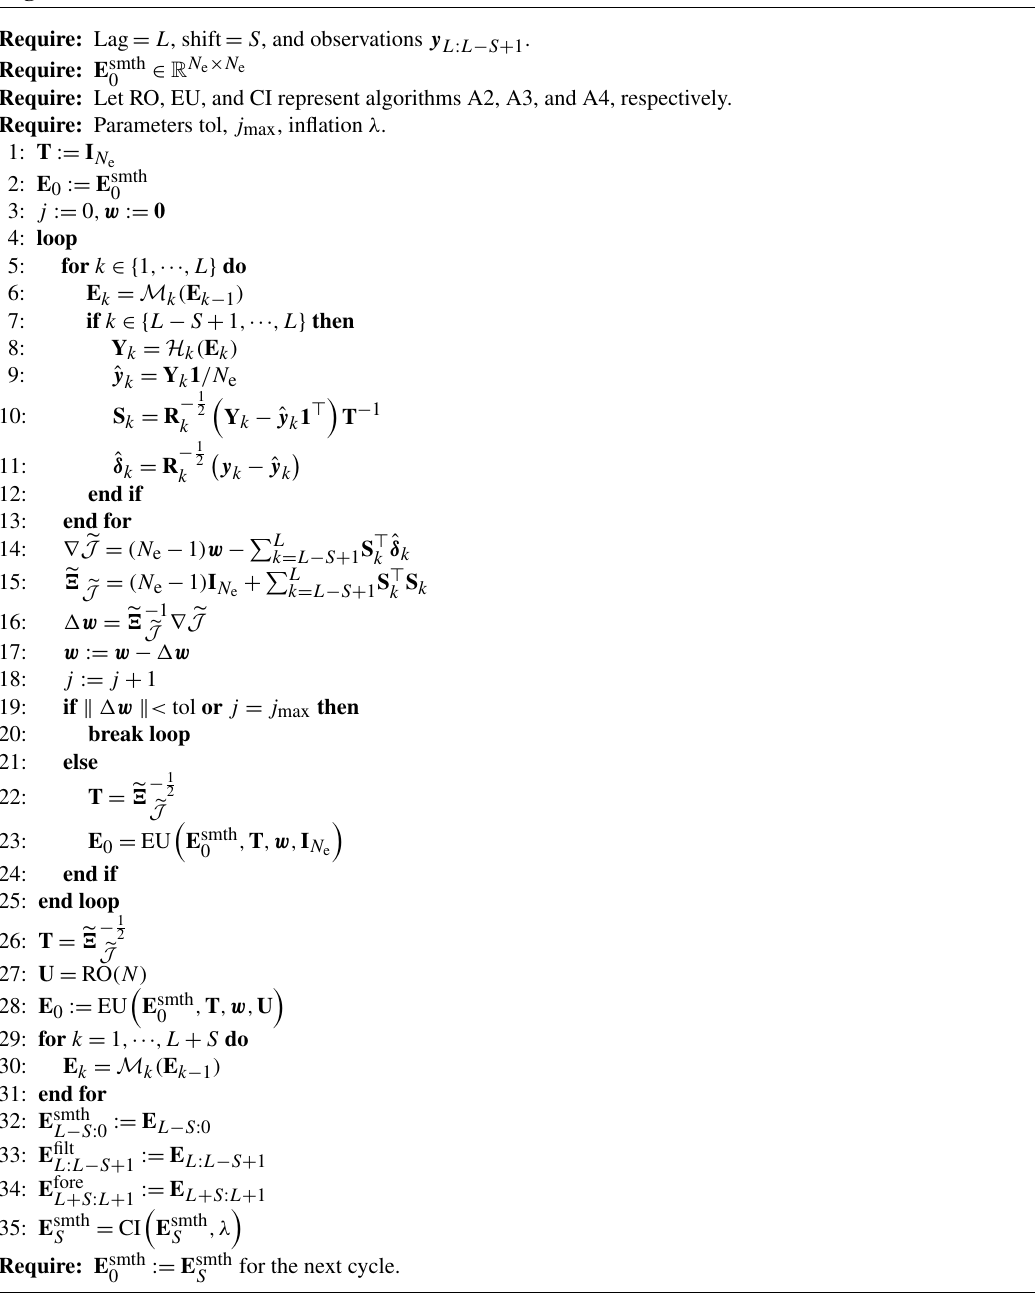
Algorithm A7 Gauss–Newton IEnKS in the SDA transform